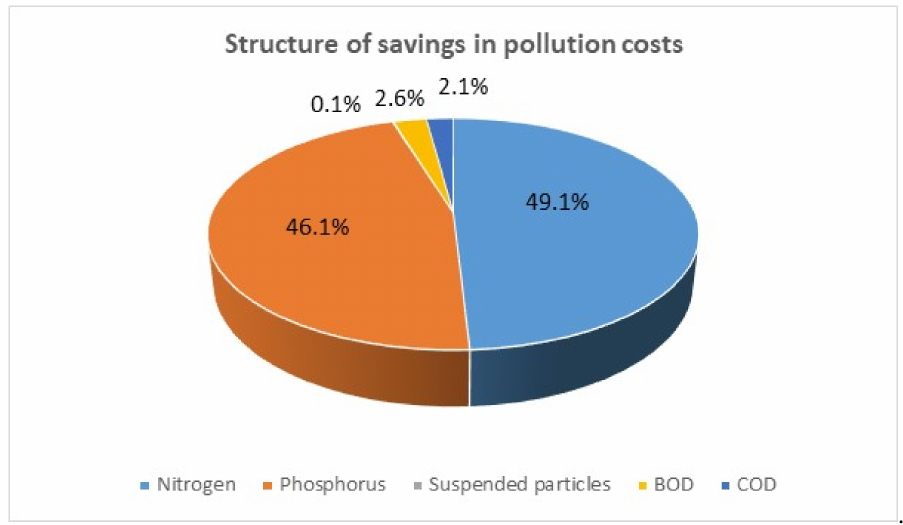
Figure 4. Structure of savings in pollution